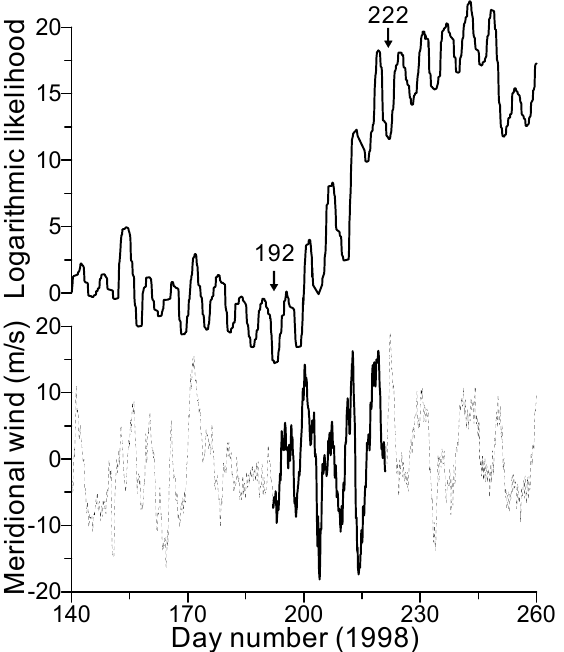
Fig. 3. Time development of the logarithmic likelihood for the pe- riod of 5.9 days in the UK meridional wind (top) and of the 51-h running mean values of the UK meridional wind (bottom). The re- sults are plotted for the time interval from 17 May to 17 September 1998. The arrows in the top plot indicate the time interval when the oscillation is in operation. The thick line in the bottom plot enhances this interval.